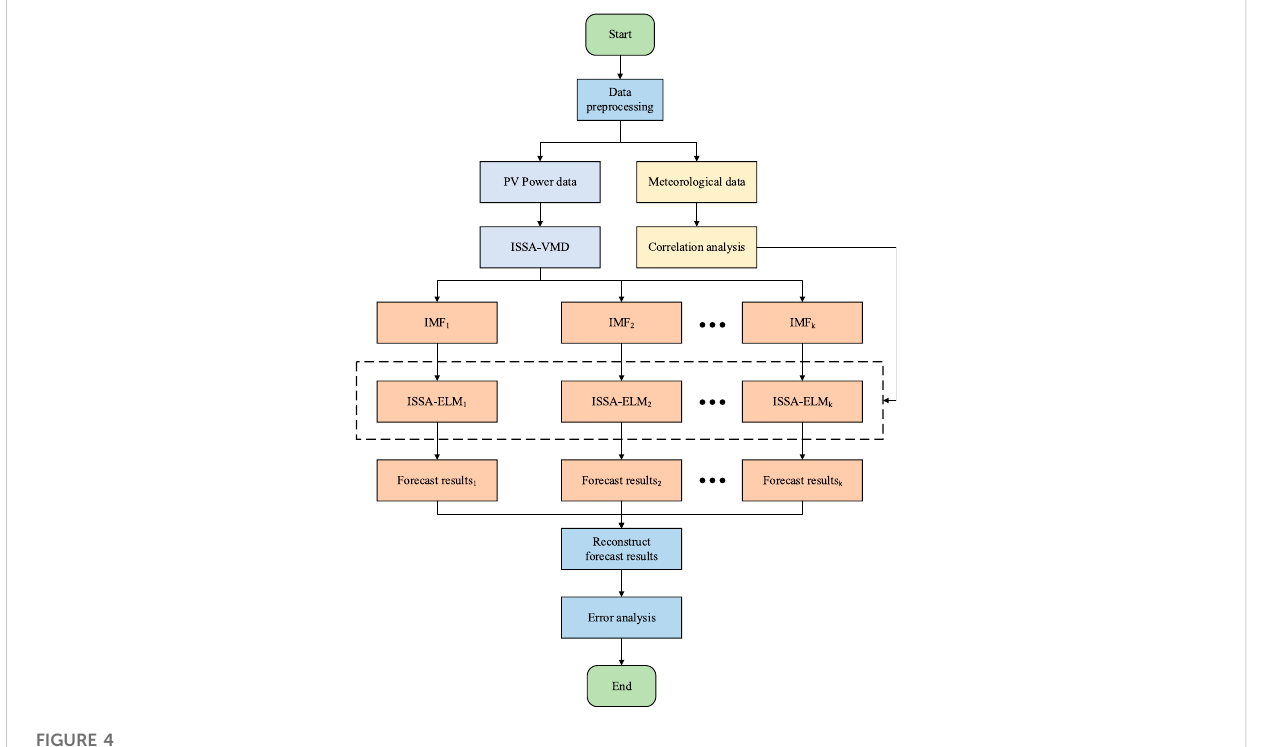
FIGURE 4 The forecasting model ’ s fl owchart.